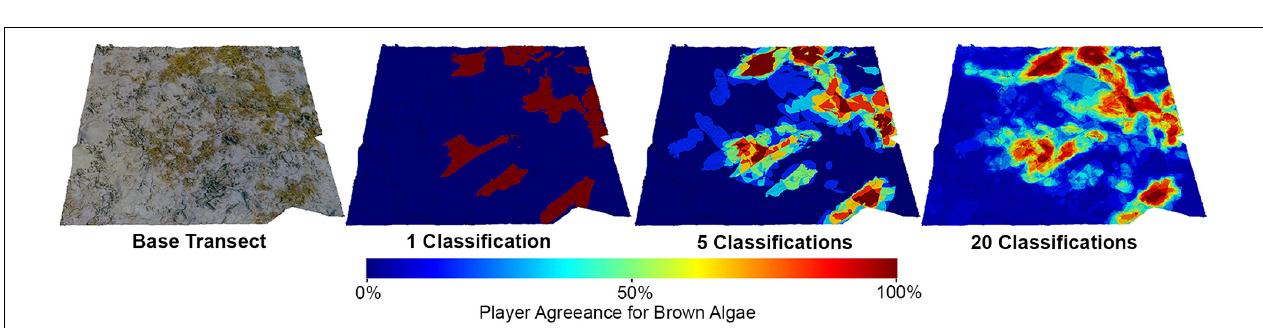
FIGURE 9 | Linear least-squares regression plot and 95% confidence interval of class labels’ average percent cover and Jaccard indices. Shows a positive trend between the average percent cover and the Jaccard index of class labels, with an R 2 value of 0.66. This trend indicates that the more area a class label occupies in a coral reef scene on average, the more it will be classified correctly.